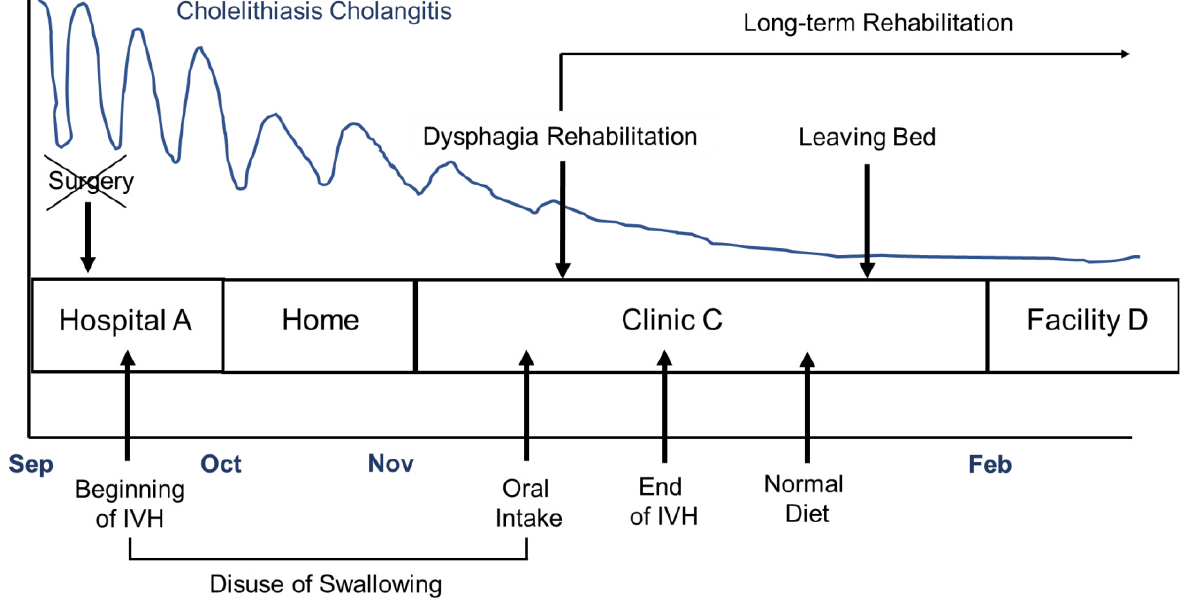
Figure 1. Clinical course and rehabilitation process. The avoidance of surgery resulted in prolonged cholangitis, very slow progress in oral intake, and long-term dysphagia